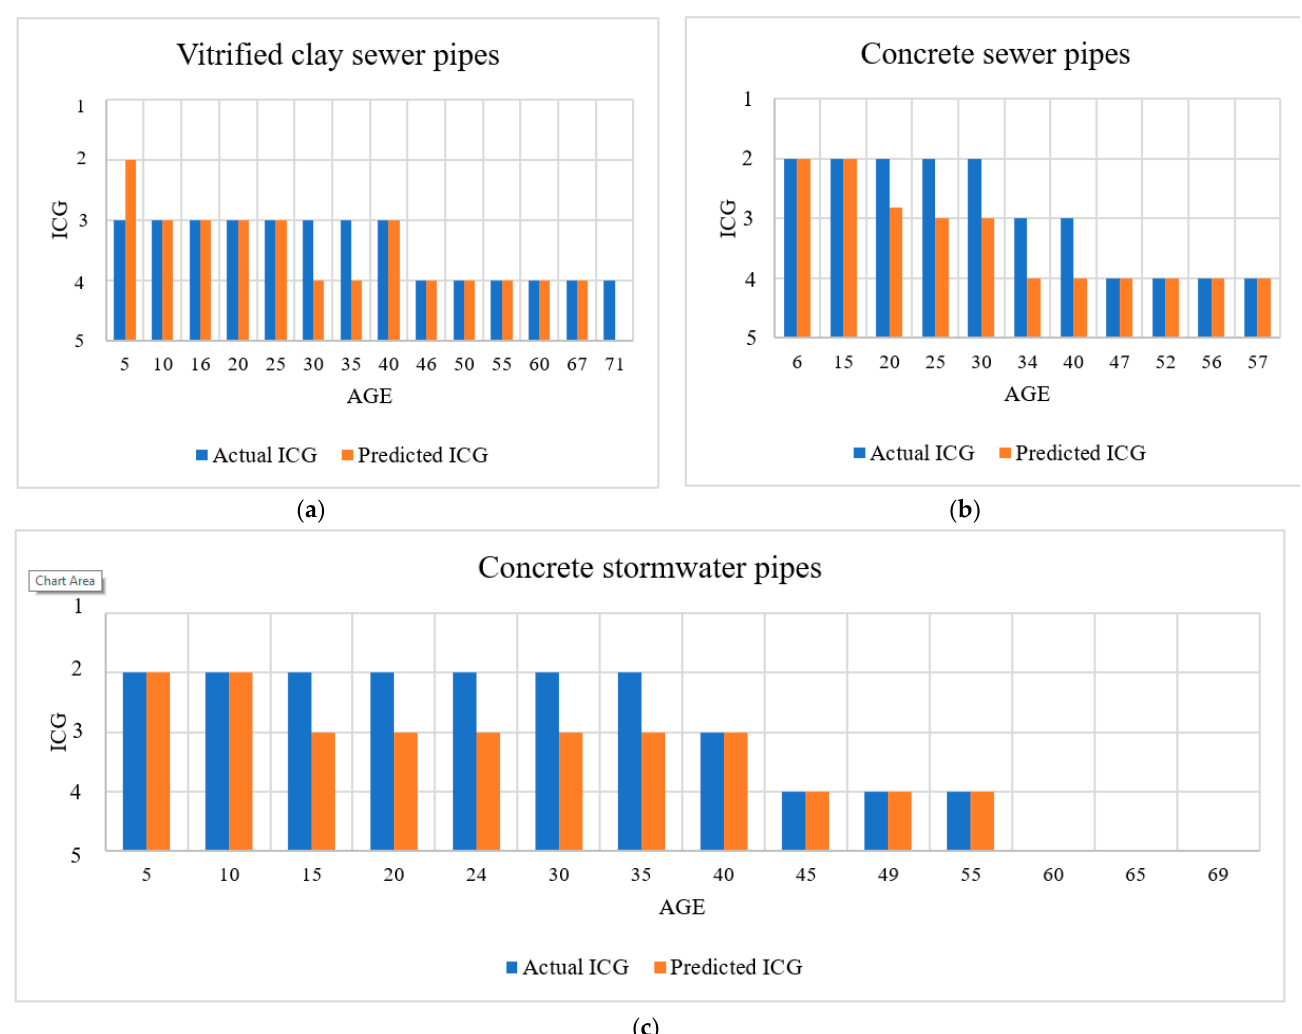
Figure 4. Actual ICG and predicted ICG for different pipe types and materials: ( a ) Vitrified clay sewer pipes, ( b ) Concrete sewer pipes, and ( c ) Concrete stormwater pipes.